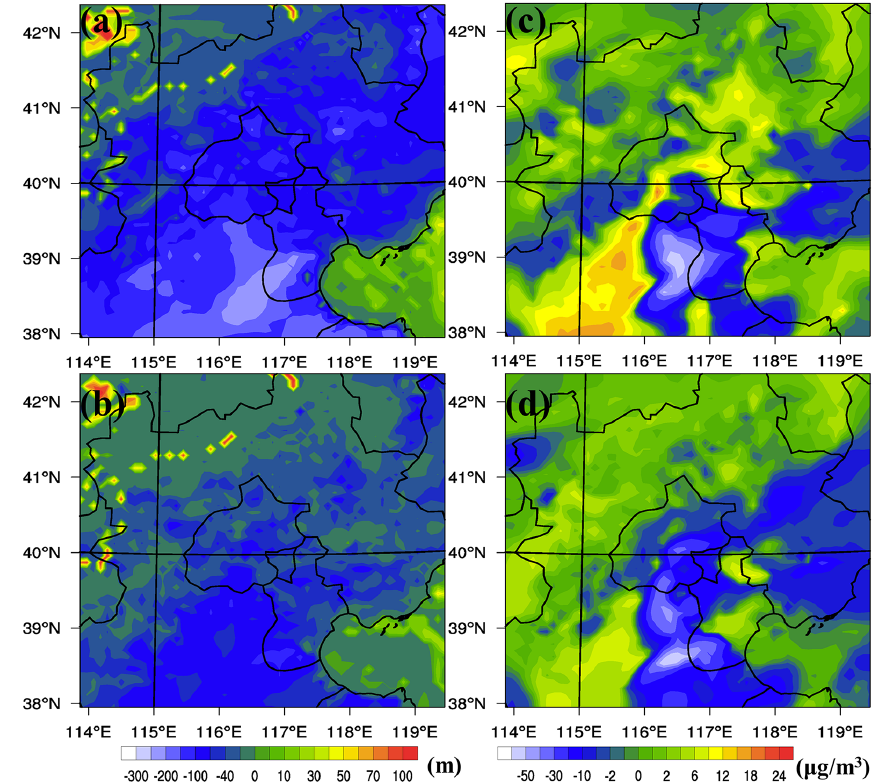
Figure 17. Differences of PBLH (unit: m) and PM 2 . 5 concentration (unit: µgm − 3 ) at 02:00p.m. between WF and NF scenarios (a, c) when BC emissions were reduced by half; differences of PBLH (unit: m) and PM 2 . 5 concentration (unit: µgm − 3 ) at 02:00p.m. between WF and NF scenarios (b, d) when BC emissions were reduced by